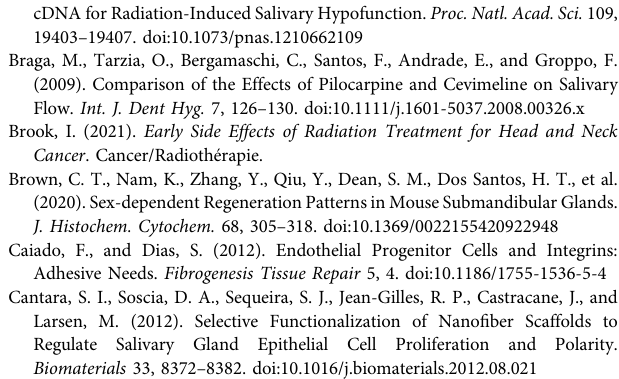
Supplemental Figure S1 | L 1p -FH does not enhance angiogenesis after radiation treatment. VCAM-1 (green) and ICAM-1 (red) were analyzed using confocal microscopy. Scale bars represent 100 µm. Representative image from a total of 5 mice per